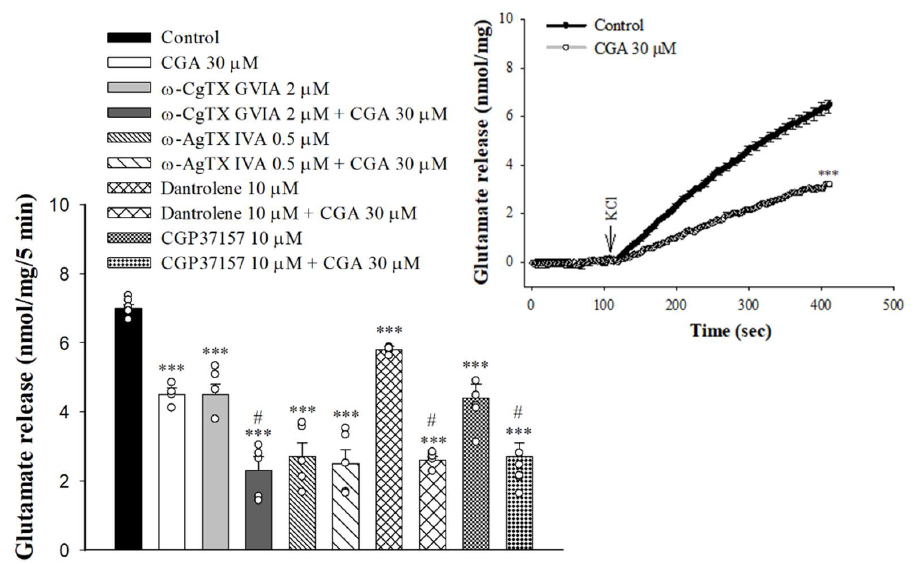
Figure 3. Effect of CGA on 4-AP-evoked glutamate release in the presence of N-type Ca 2+ channel blocker ω -CgTX GVIA, P/Q-type Ca 2+ channel blocker ω -AgTX IVA, ryanodine receptor inhibitor dantrolene, or mitochondrial Na + /Ca 2+ exchange inhibitor CGP37157. Inset, effect of CGA on the release of glutamate evoked by 15 mM KCl. CGA was added 10 min before the addition of 4-AP, and other drugs were added 10 min before this. Data are presented as mean ± S.E.M. ( n = 5 per group). ***, p < 0.001 vs. control group. #, p < 0.05 vs. ω -CgTX GVIA-, dantrolene- or